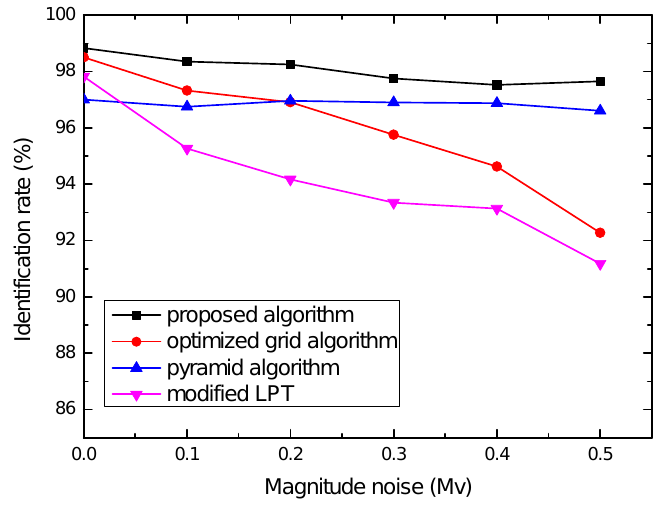
Figure 7. Identification rate versus magnitude